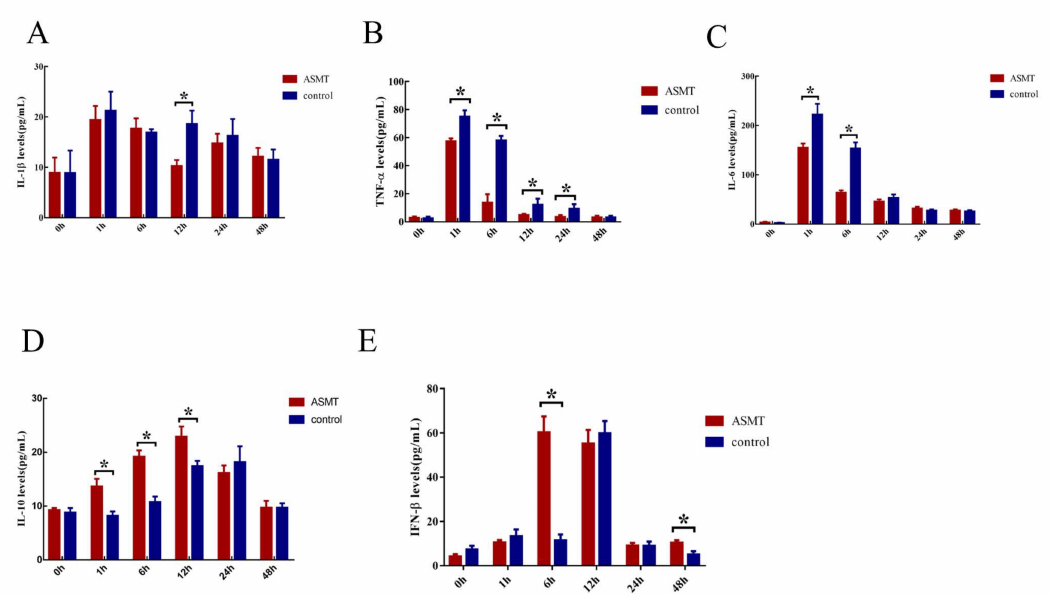
Figure 6. The effects of E. coli injection on inflammatory cytokines in transgenic (ASMT) and WT goats. ( A ) IL-1 β ; ( B ) TNF- α ; ( C ) IL-6; ( D ) IL-10; ( E ) IFN- β . Note: the transgenic goat ( n = 3), wild type ( n = 3), * represents significant differences between the two